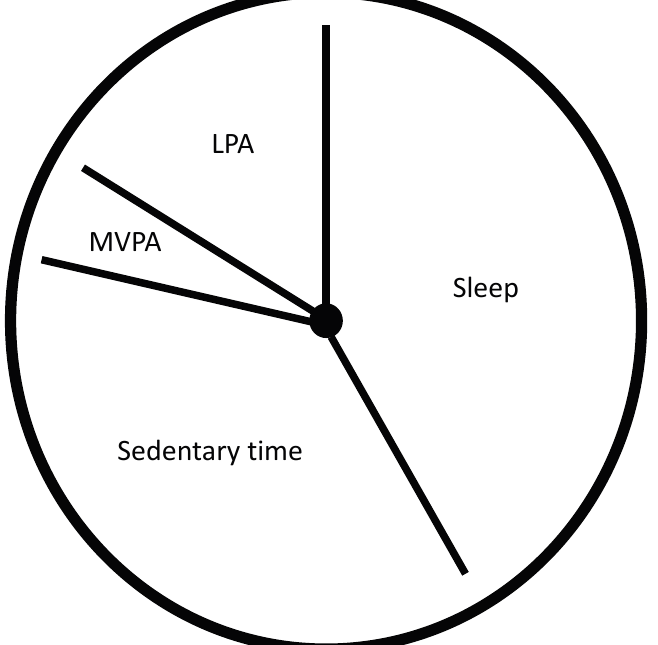
Figure 1. Estimated distribution of movement behaviors over the 24 h